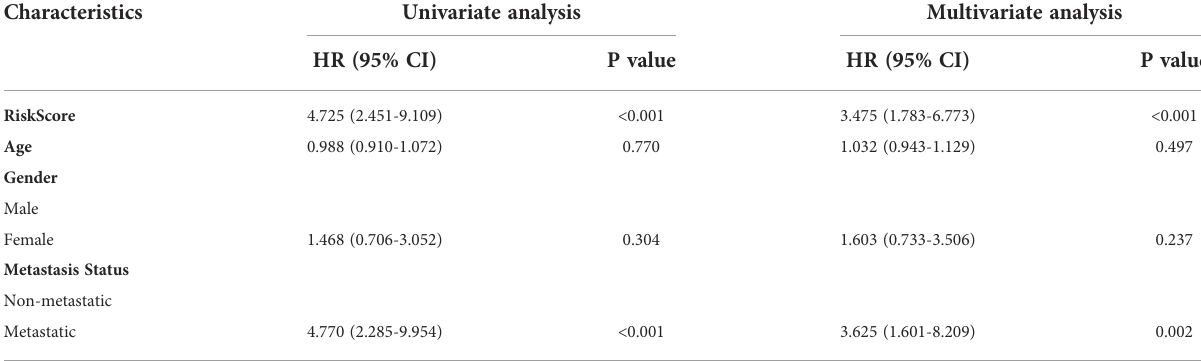
TABLE 1 Univariate and multivariate Cox proportional hazard model for overall survival based on the Target-OS cohort.